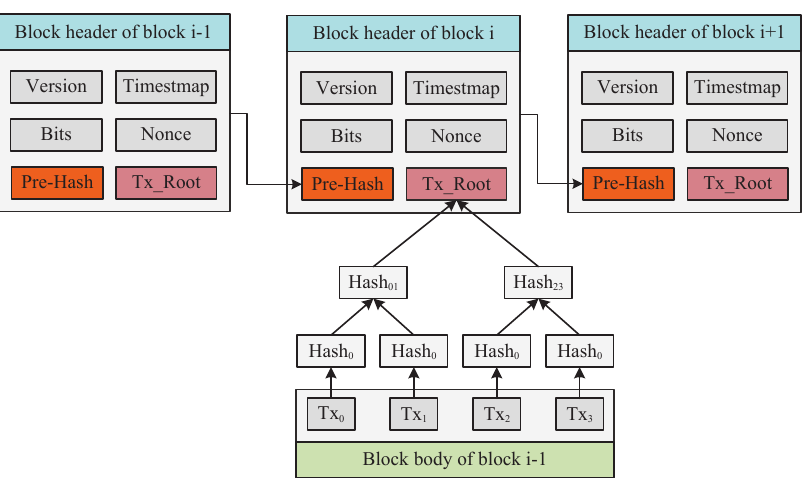
Figure 4. Blockchain data-layer